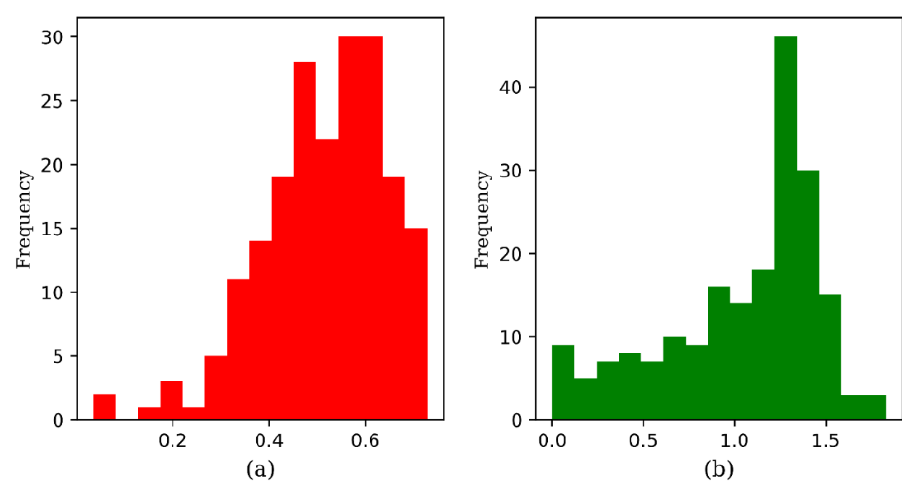
Figure 12. Distribution of output feature: ( a ) conversion efficiency ( b ) non-dimensional significant wave force on the barrier at T E = 5 s in irregular waves.